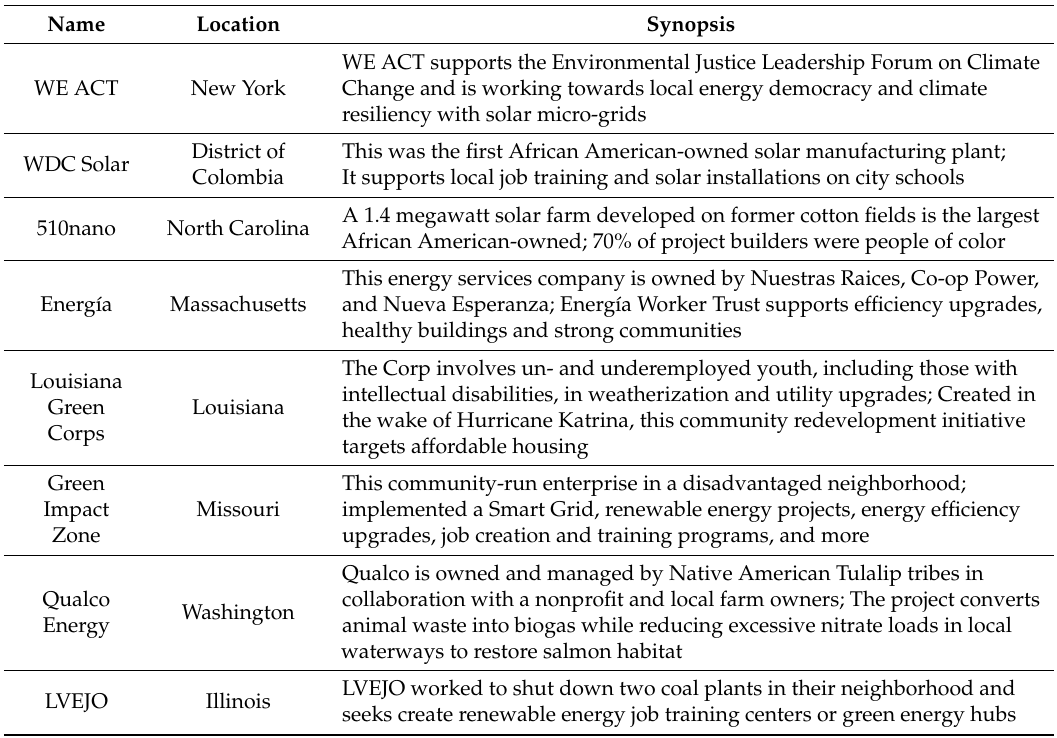
Table 7. Illustrative energy justice cases.